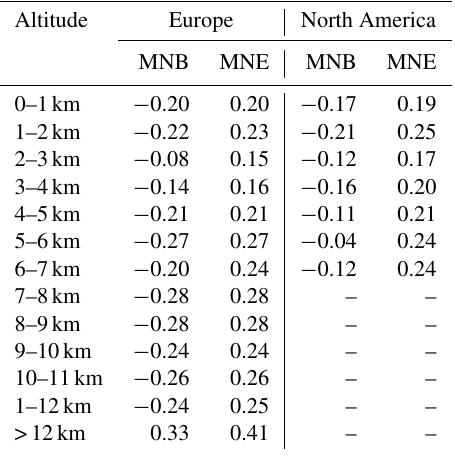
Table 4. Model ensemble vertical distribution of model mean nor- malized bias (MNB) and mean normalized error (MNE) for GEM in Europe and North